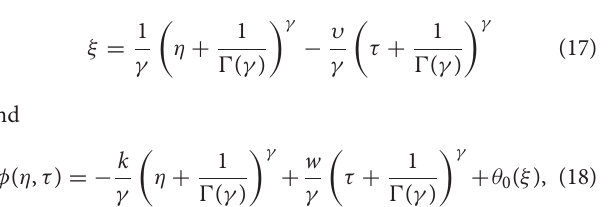
0.5, β 0.9 for (27). = =